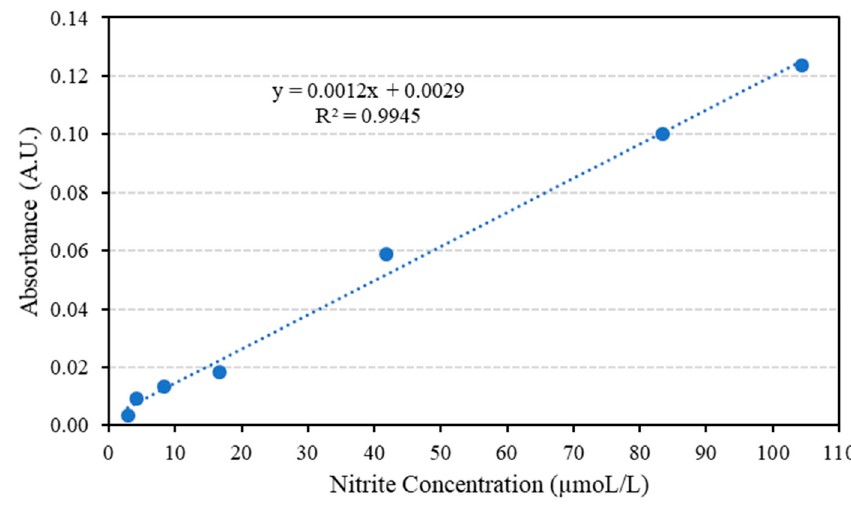
Figure 5. The average absorbance for nitrite solutions of various concentrations.